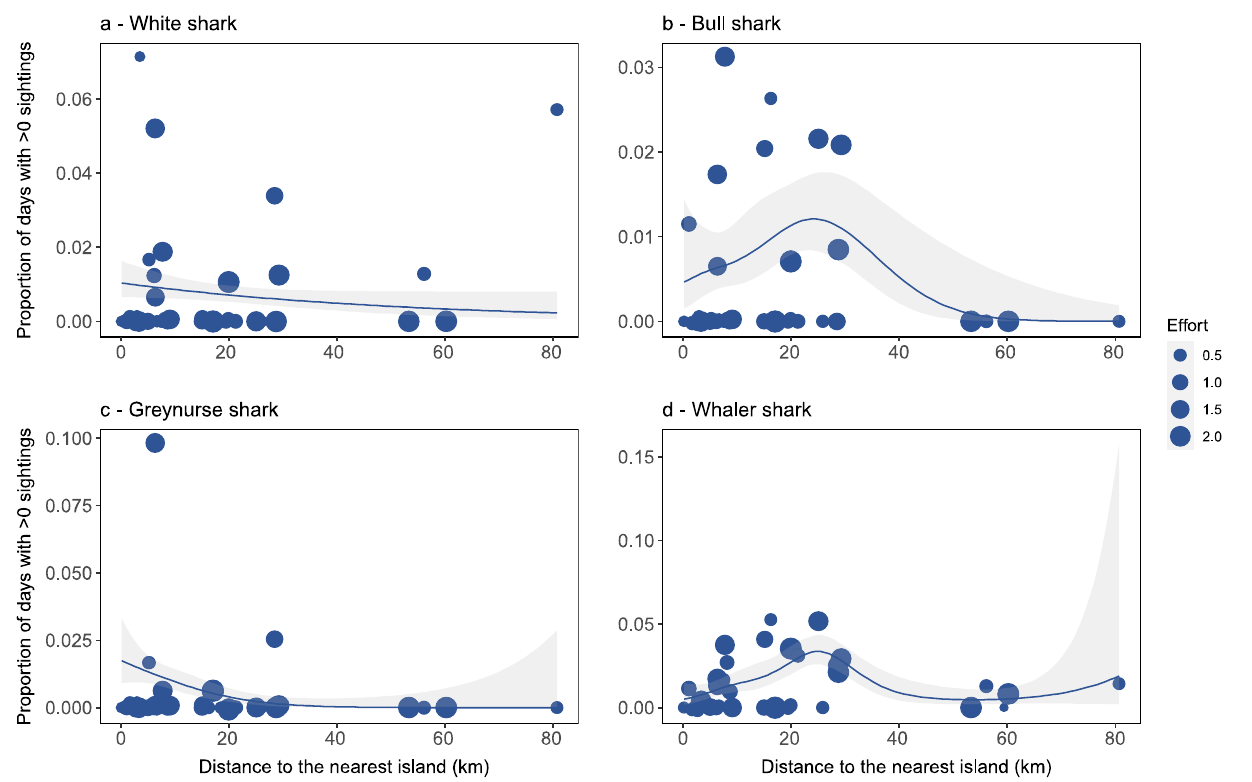
Figure 4. Detection rates for each beach location in relation to distance to the nearest island for ( a ) white shark, ( b ) bull shark, ( c ) greynurse shark, and ( d ) whaler shark species, and estimated response curves with a 95% confidence region. Points are sized proportionally to the total flight effort at each location proportional to the average effort. Thus, a weight of 1.0 equals average flight effort, <1 equals below average effort, and >1 equals above average effort.